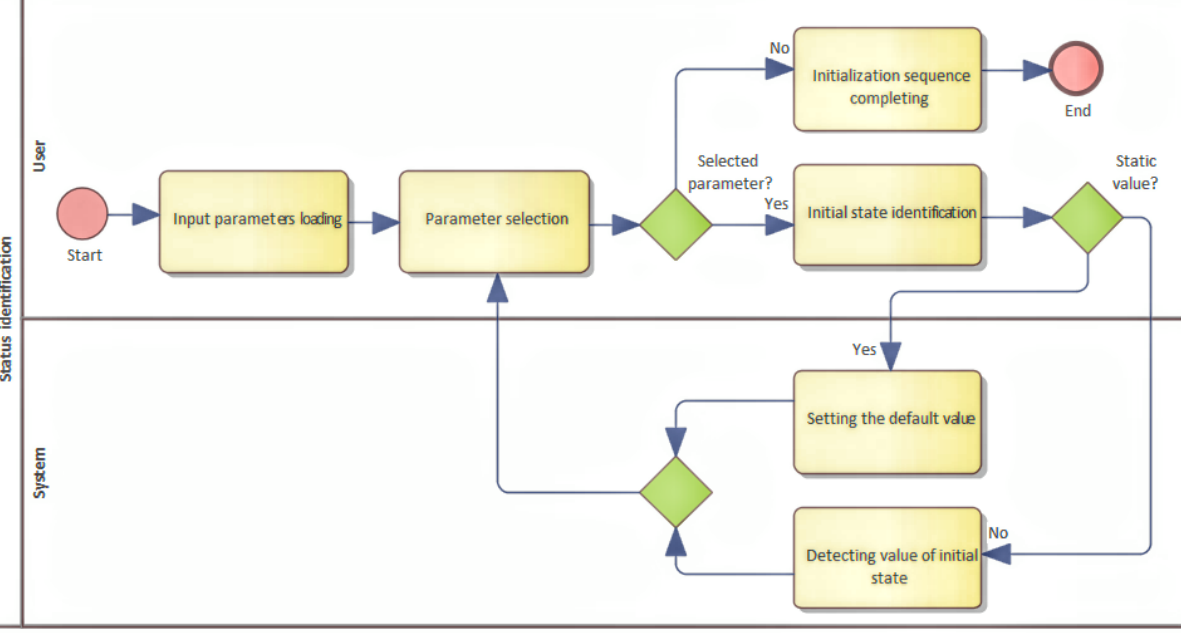
Figure 8. An identification of initial values and states of the device.